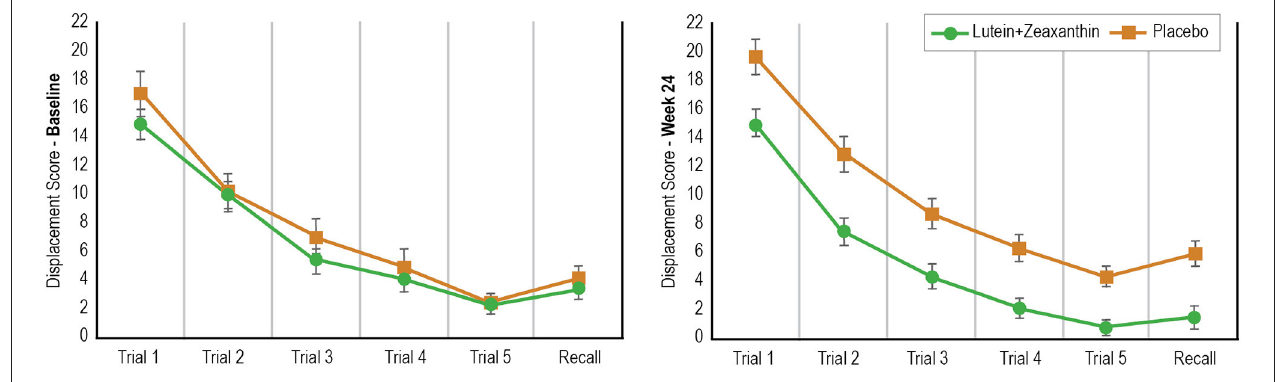
FIGURE 2 | Change in Performance on the Location Learning Task from Baseline to Day 180.